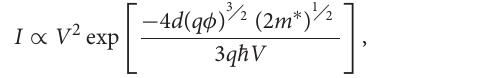
law of I ∼ V 1.87 , I ∼ V 1.06 , and I ∼ V 1.23 for 20, 80, and 120 ◦ C, respectively. The exponent value at 20 ◦ C was close to two, indicating the I–V relationship approaches the space-charge- limited current (SCLC) electric model at this temperature. At